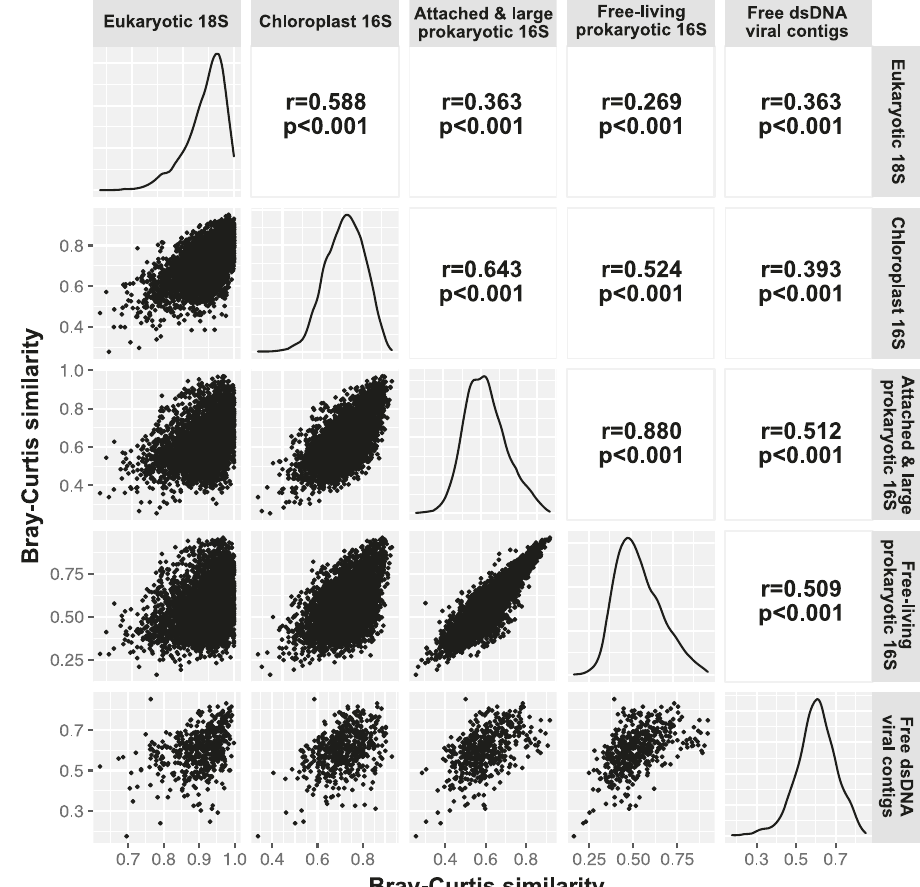
Fig. 4 | Mantel test showing correlations among different microbial compo- nents. Scatterplots of each pair of beta-diversity (i.e., Bray – Curtis similarity) are shownontheleftpartofthe fi gure.TheresultsofeachManteltestareshownonthe right. The distribution of beta-diversity of each component is shown on the diag- onal. The results show that free-living and particle-associated prokaryotic